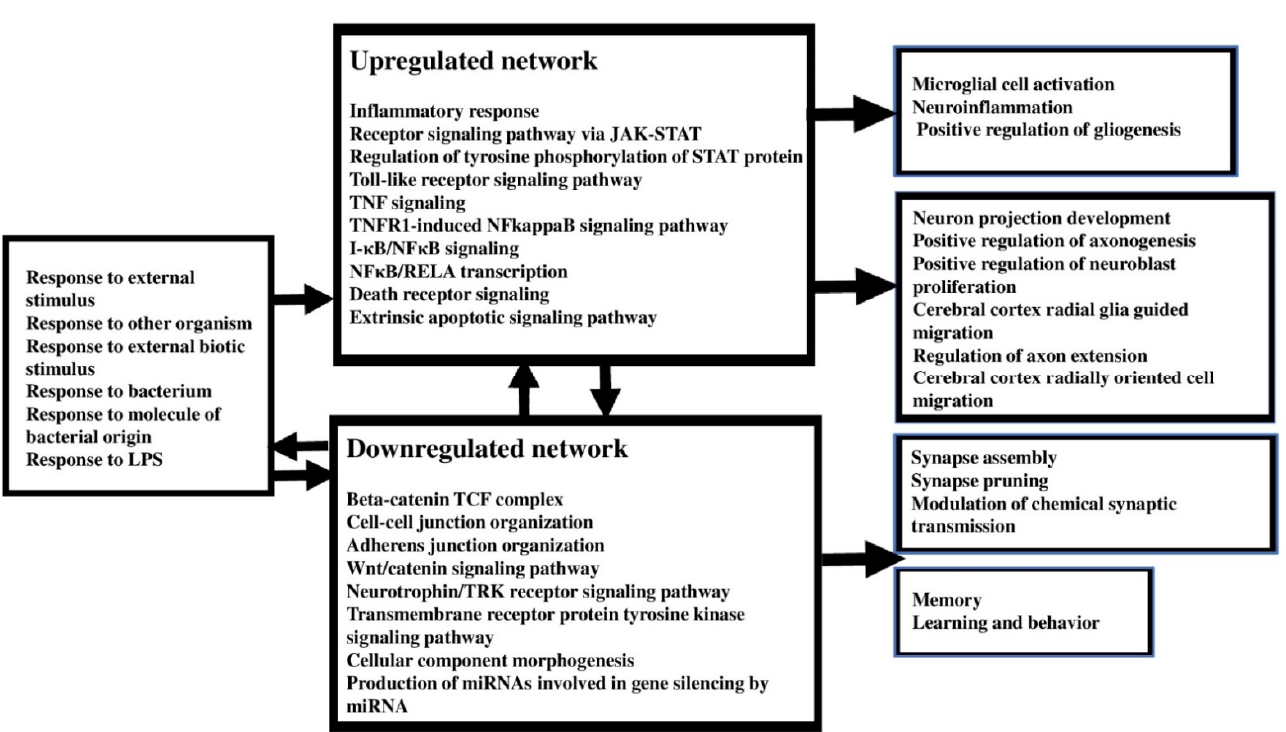
Figure 9. Summary of the findings of the enrichment/annotation analysis using upregulated and downregulated genes in first episode psychosis and schizophrenia.